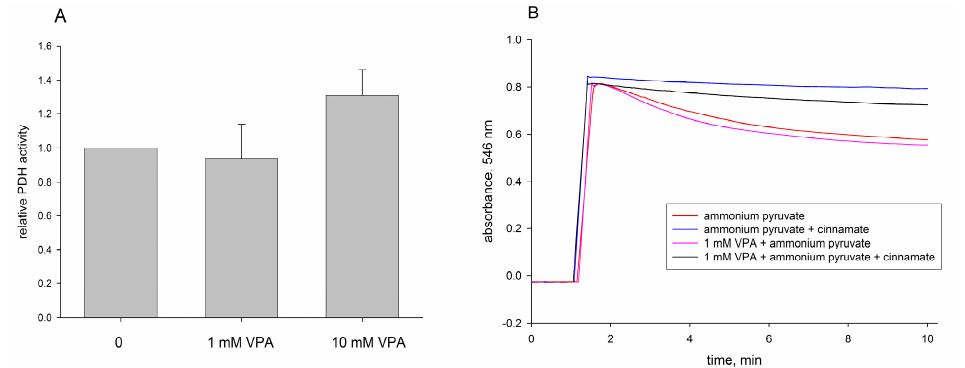
Figure 4. Effect of VPA on pyruvate dehydrogenase activity ( A ) and pyruvate transport activity ( B ) of isolated rat liver mitochondria. Liver mitochondria (2.8–3.6 mg protein/mL) were preincubated for 3 min in presence of 1 mM ATP, 5 mM MgCl 2 with the indicated amount of VPA. ( A ) The plotted pyruvate dehydrogenase (PDH) activities are averages of three independent experiments; ( B ) Swelling of mitochondria in 0.1 M ammonium pyruvate buffer. One representative experiment (out of 3) is shown. Red trace: control; pink trace: 1 mM VPA; blue trace: 1 mM cinnamate; black trace: 1 mM VPA and 1 mM cinnamate. Experimental conditions as described in Materials and Methods.